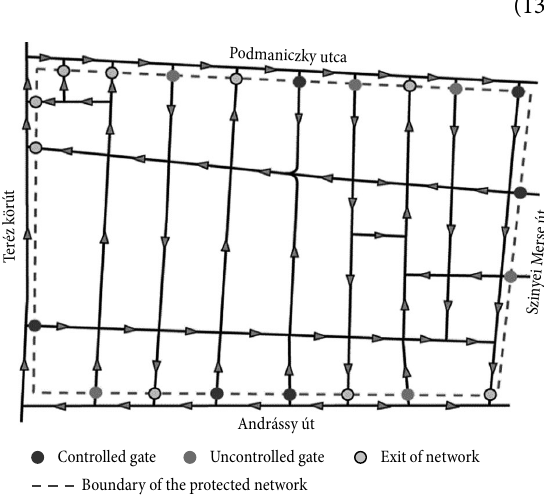
Fig. 1. Network layout